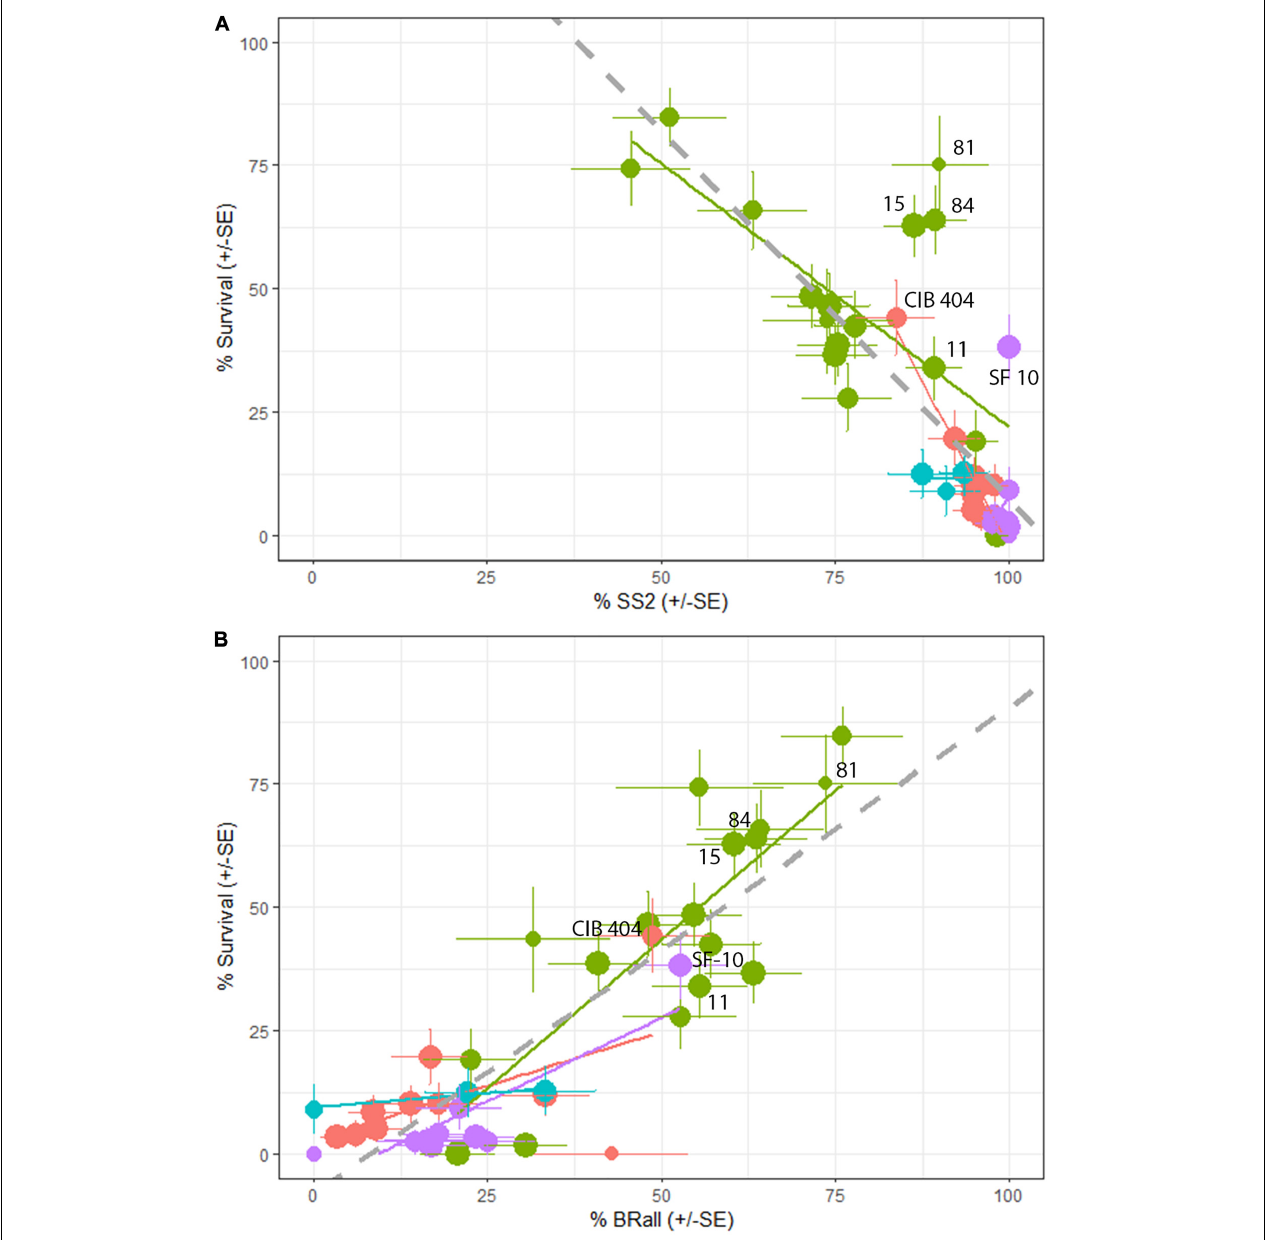
FIGURE 6 | (A) Final family percent survival is negatively associated with percent stem symptoms at 2nd assessment (%SS2; P < 0.001). Lincoln R (green) had significantly lower percent stem symptoms and higher overall survival compared to Lincoln S (blue), Cibola (pink) and Santa Fe (purple) National Forests. (B) Family percent bark reactions + partial bark reactions (BR all 7 ) were positively and significantly related to overall survival ( P < 0.001). Lincoln R had significantly more BR all than either Cibola or Santa Fe forests. Error bars ± SE point size increases with the number of seedlings in a family. Seed families that have % SS2 > 80% and % Survival > 25% are labeled in both